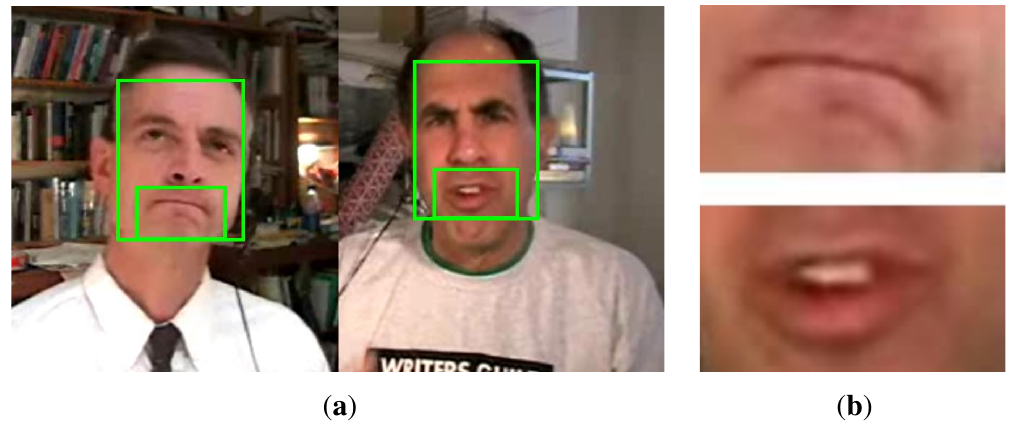
Figure 2. ( a ) Face and mouth detection and ( b ) segmented mouth